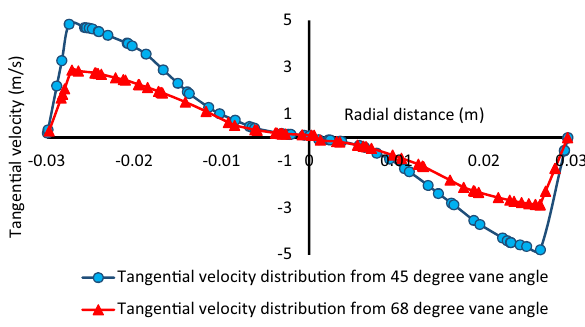
Fig. 11 Radial distribution of tangential velocity at Z = 90 mm of the LLHC for 45° and 68° with an inlet velocity of 2.0